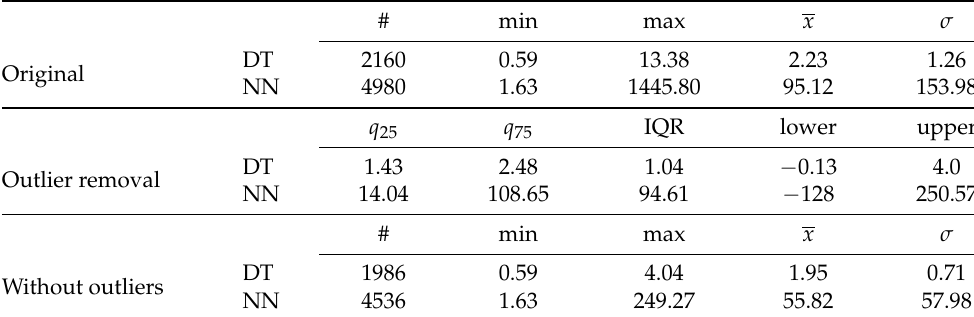
Table 5. Some statistics regarding the duration variable for both datasets, before and after the remotion of the outliers. These were used in the computation of the MAE(%) metric.